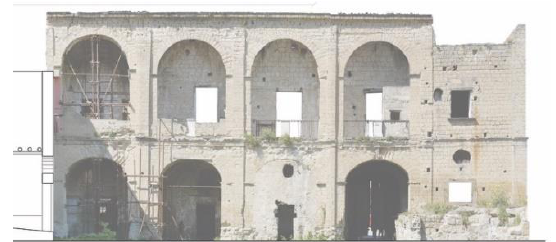
Figure 10. Conservation status of Masseria San Lorenzo : section of the court. ©Restoration project of Masseria